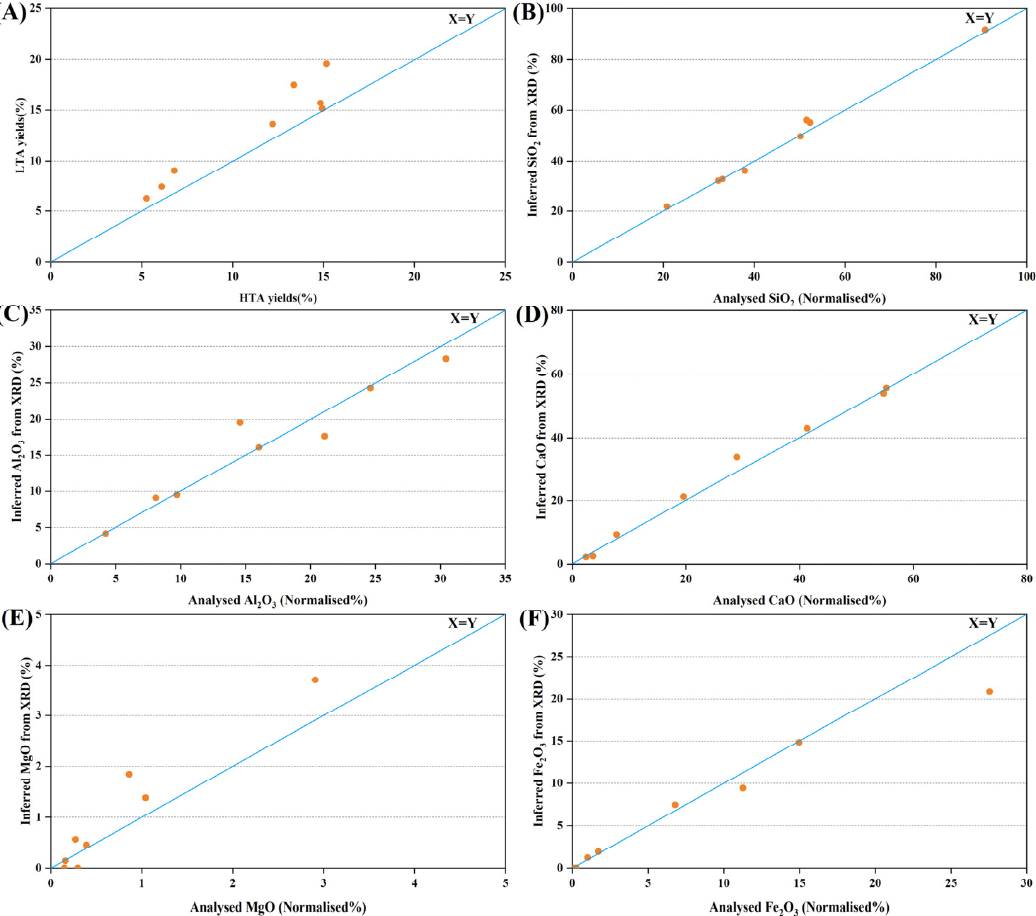
Figure 8. ( A ) comparison of the low- and high-temperature ash yields; ( B – F ) observed normalized oxide percentages from chemical analysis ( x -axis) to oxide percentages for sample ash inferred from XRD data ( y -axis). The diagonal line in each plot indicates equality. LTA, low-temperature ash yield; HTA, high-temperature ash